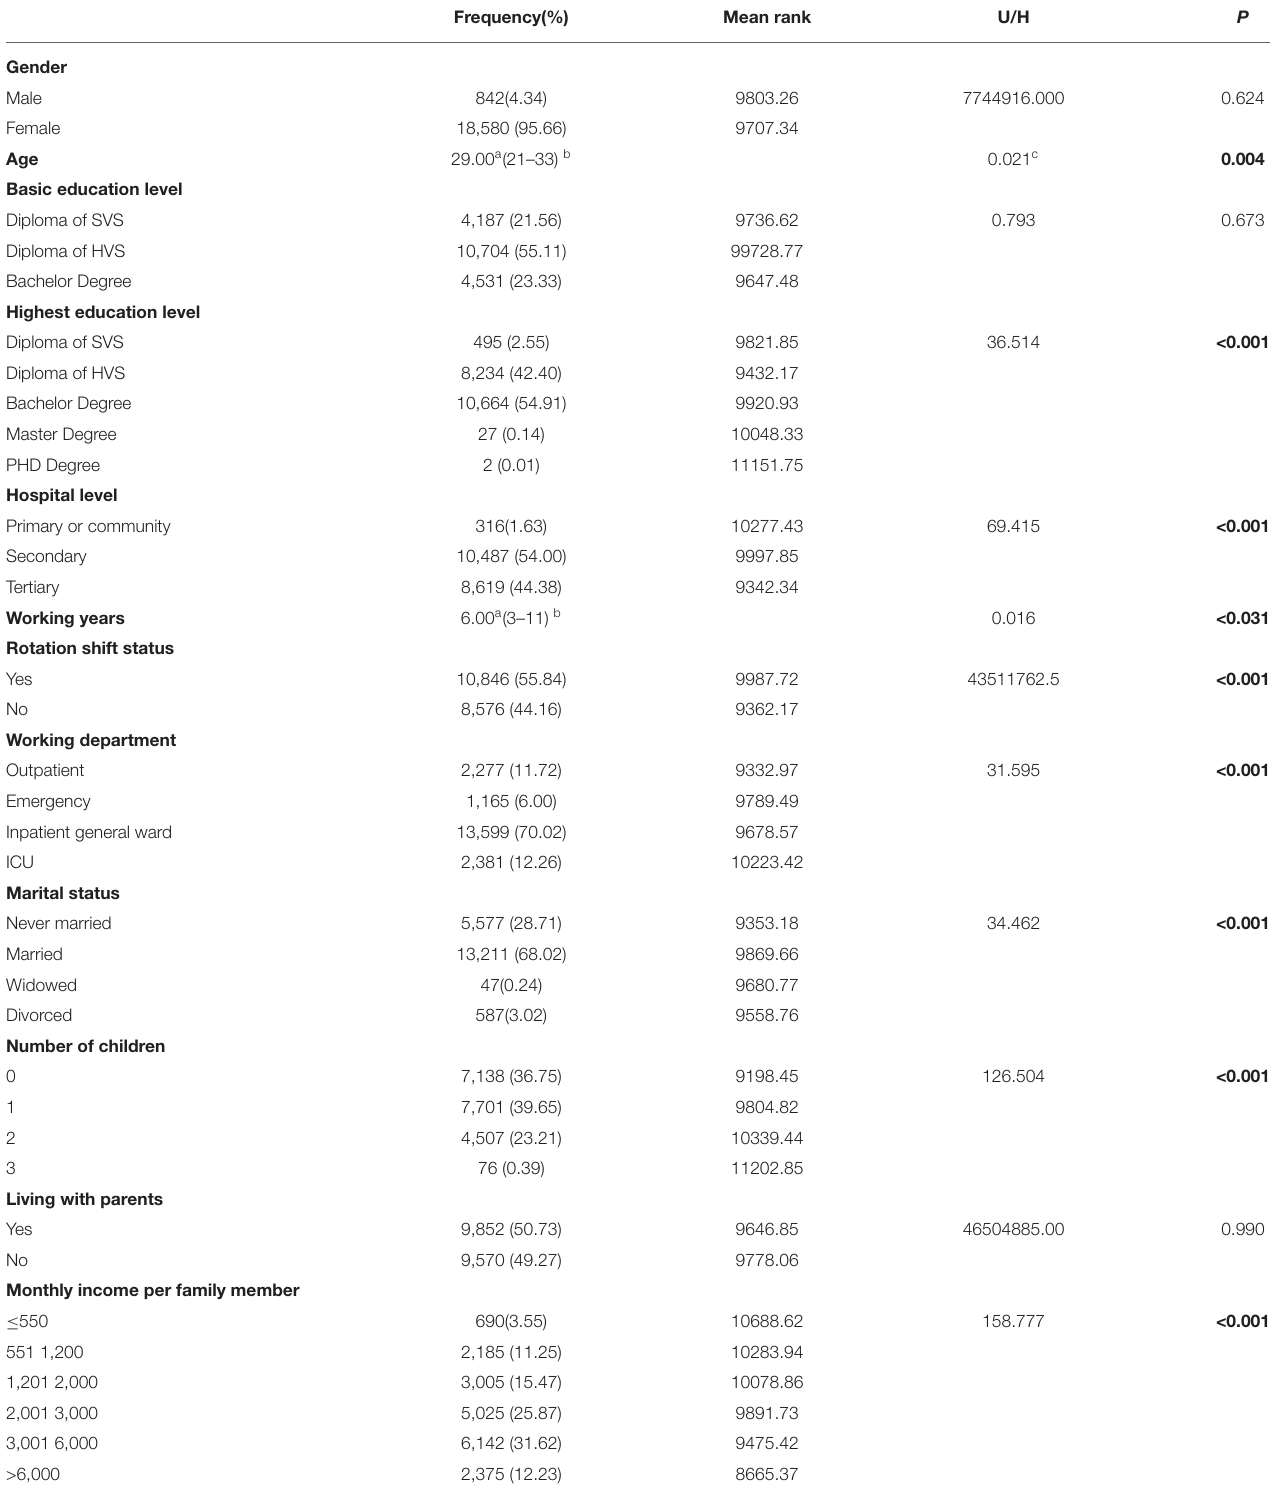
TABLE 1 | Demographic characteristic and outcome of univariate analysis ( N =